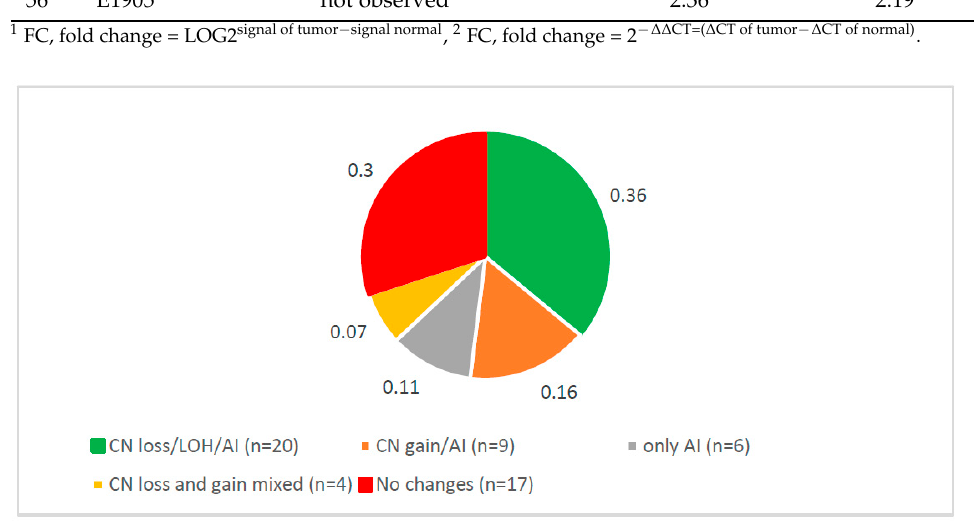
Figure 1. Distribution of somatic DNA alterations on CSMD1 in 56 ESCC.